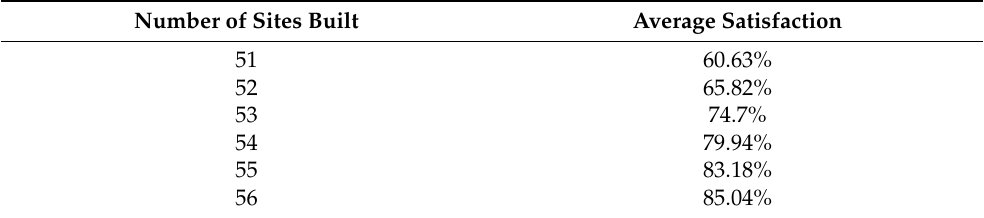
Table 2. Sensitivity analysis of the number of electric vehicle charging stations constructed.